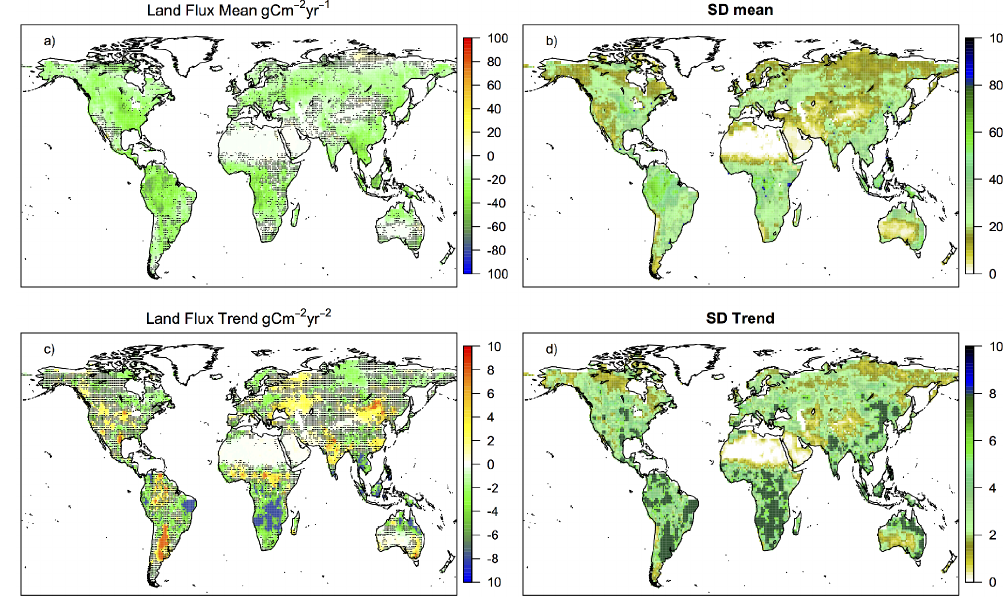
Figure 5. (a) Average land to atmosphere net CO 2 flux over the period 1990–2009 for the ensemble mean and model disagreement, with stippling representing agreement for <66% of DGVMs , and (b) standard deviation across DGVMs. (c) The trend in land to atmosphere net CO 2 flux across the ensemble, and model disagreement, with stippling representing agreement of <66% of the DGVMs , and (d) the standard deviation of the trend.